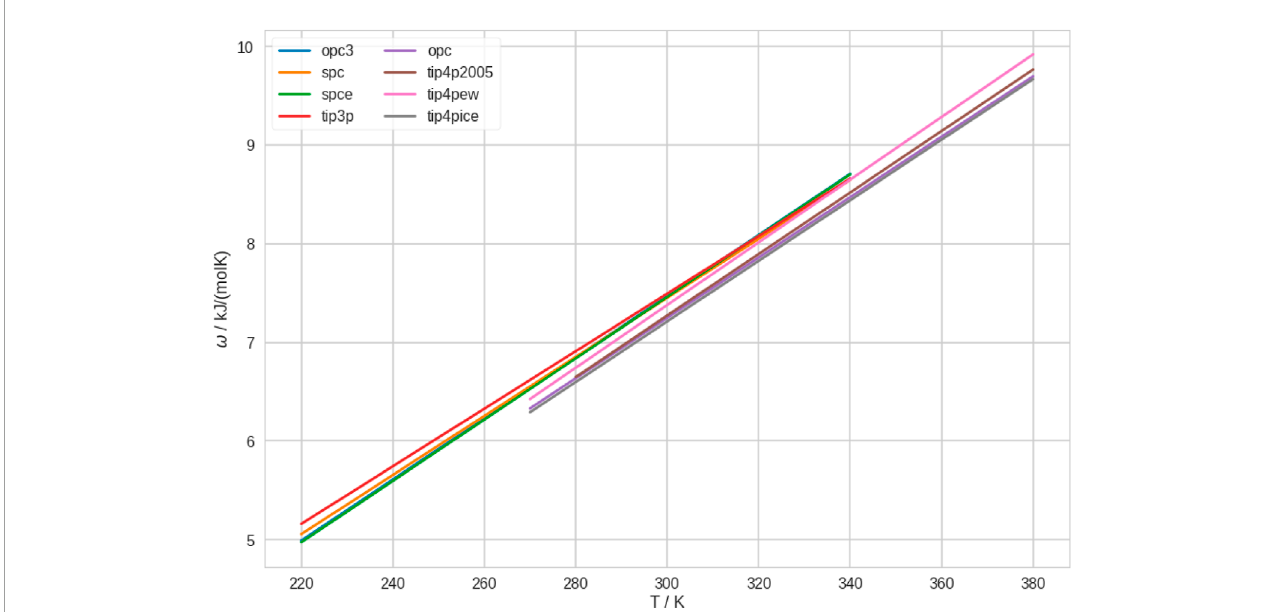
FIGURE 3 Polymer-solvent affinity, ω , in different water models. We quantified this property by the potential of mean force between polymer and solvent. For clarity, we only show the fitting lines here. The independent linear fits with the raw data can be found in Supplementary Figure S15 .